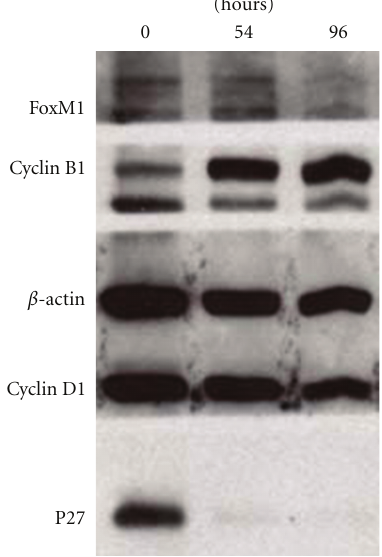
Figure 1: E ff ect of p27 kip1 silencing on the expression of islet cell cycle proteins. Total islet cell protein contents of targeting islets were prepared right after isolation (0hr) and at 54 and 96 hours (hrs) after viral infection; separated on a 12% SDS gel and electrophoretically transferred onto nitrocellulose membranes. After checking transfer e ffi ciency, the membrane was blocked and incubated overnight in bu ff er containing 2 μ g/mL each of rabbit antibodies against mouse p27 kip1 , cyclin D1, β -actin, cyclin B1, and FoxM1; incubated with horseradish peroxidase-conjugated goat anti-rabbit immunoglobulin G antibody. The bound antibodies were detected by using chemiluminescent kit and film development.